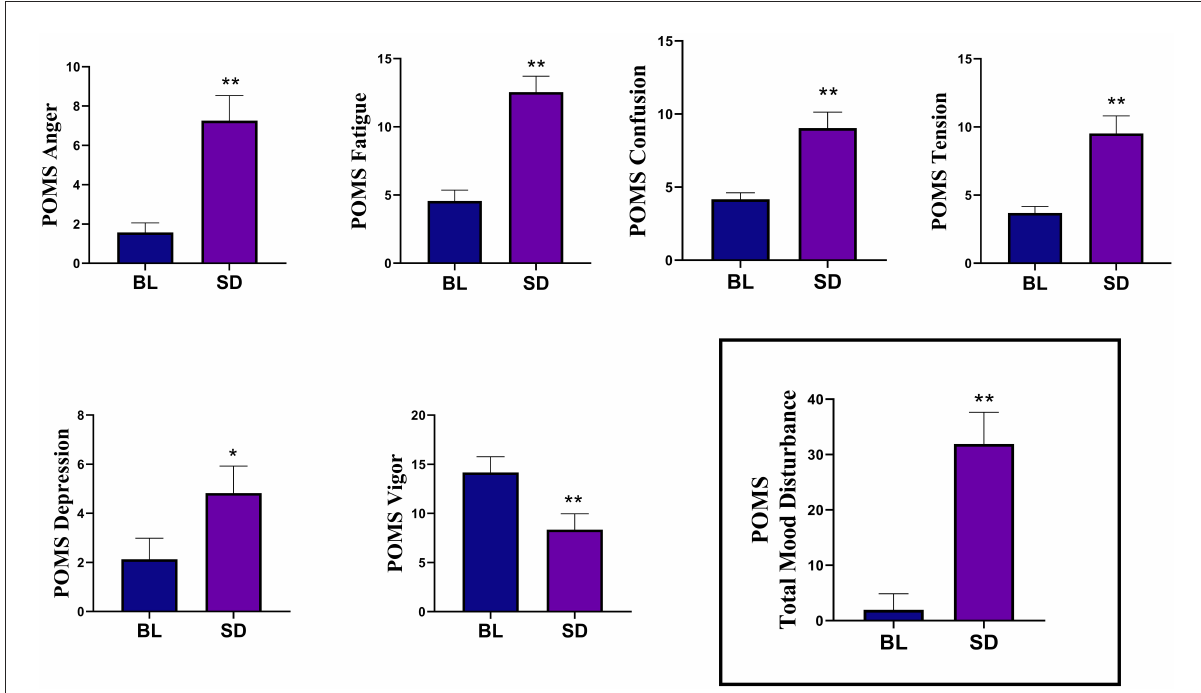
FIGURE3 The results of the Profile of Mood States (POMS) measures showed that compared to baseline (BL), sleep deprivation (SD) significantly increased in tension, depression, anger, fatigue, and confusion. There was a significant decrease in vigor. The Total Mood Disturbance composite score was also significantly increased. Errors bars represent SEM, asterisks indicates p < 0.05, and double asterisks indicate p < 0.01.